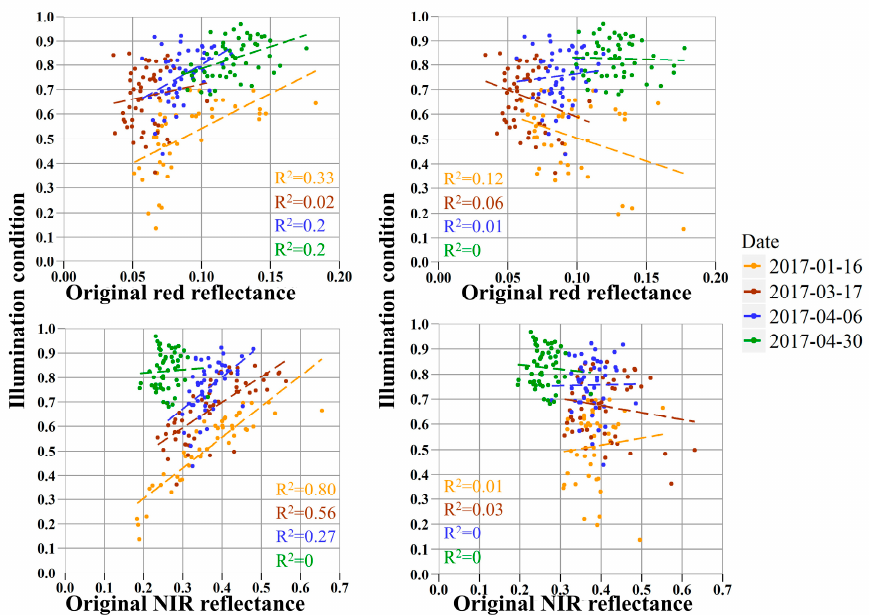
Figure 4. Scatterplots of red ( top panels ) and NIR reflectance ( bottom panels ) vs. the illumination condition (IC) for 200 pixels with biomass clipping as shown in Figure 1. Raw reflectances are shown in left column ( a , c ), and corrected reflectances in right column ( b , d ).